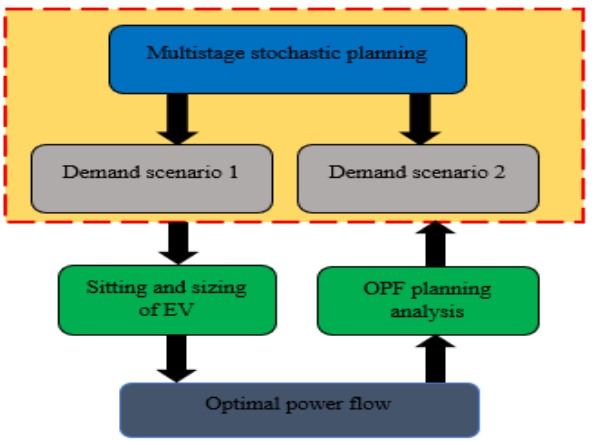
Figure 4. Multistage stochastic planning for EV charging and optimal power flow analysis.